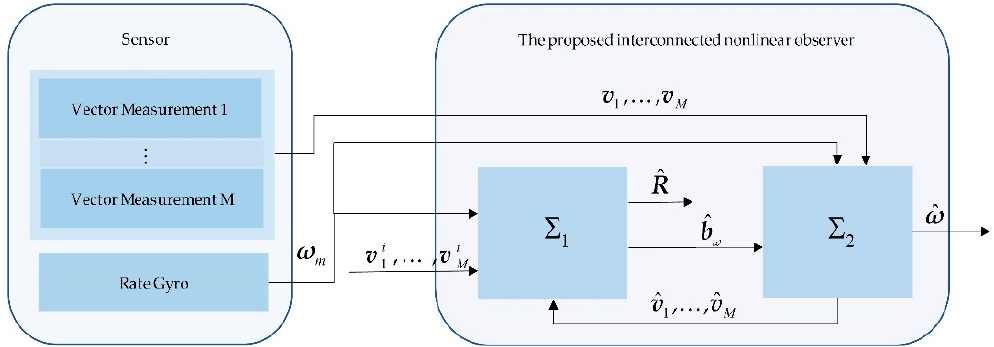
denotes the attitude observer.  1